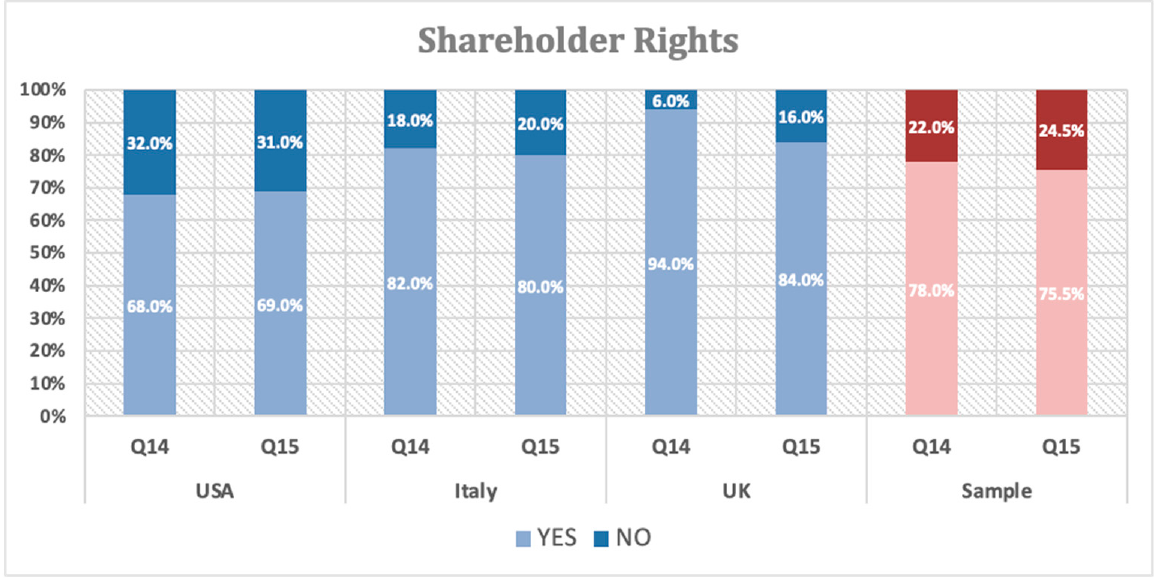
Figure 7. Answers to questions about the shareholder rights (14 and 15) by country of respond- ents.